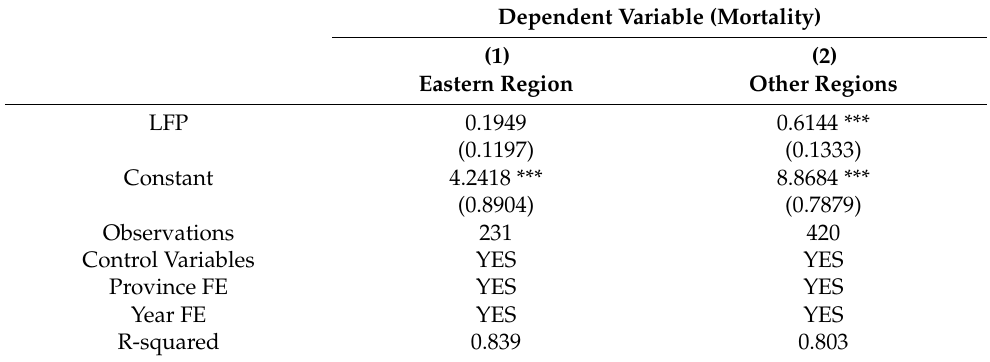
Table 5. Heterogeneity analysis